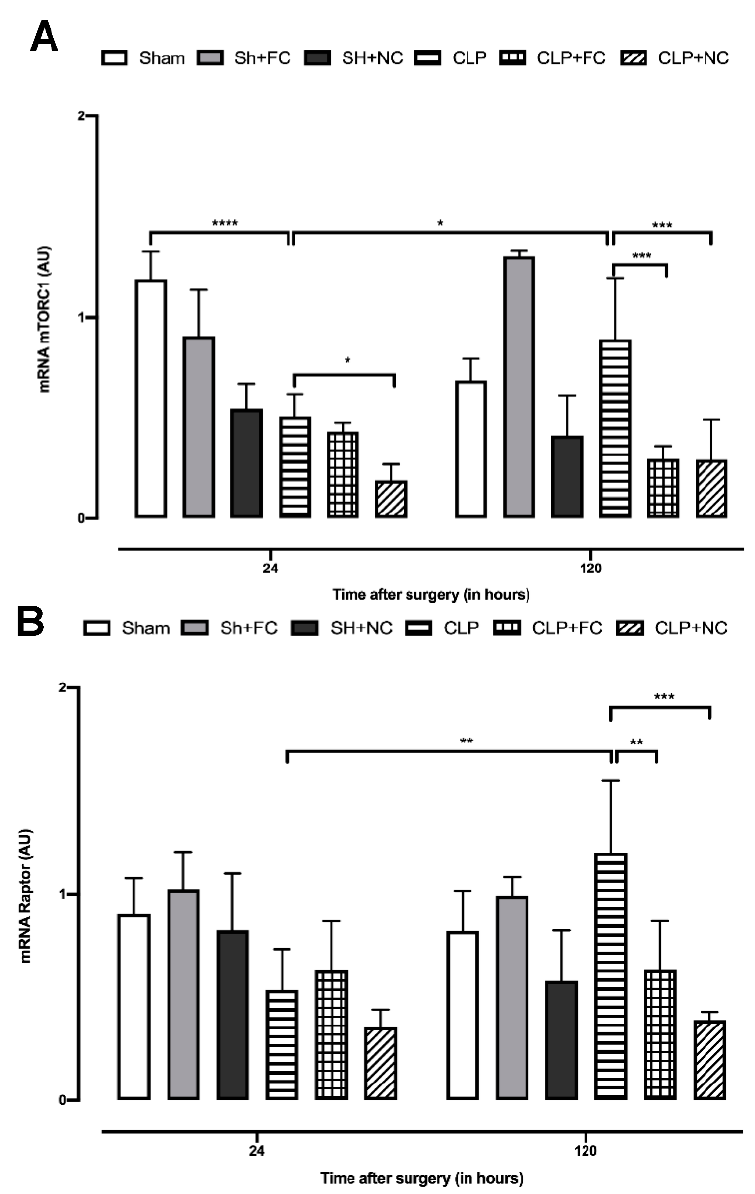
Figure 4. Real-time PCR gene expression profile analysis of mTOCR1 and Raptor in the heart of curcumin-treated and non-treated septic animals. ( A ) Assessment of mTORC1 mRNA levels shows that the septic group (CLP) had a significant reduction ( p < 0.001) compared to the control (SHAM) at 24 h and an increase at 120 h ( p < 0.05). The group of septic animals when treated with nanocurcumin (CLP + NC) showed a reduction in mTORC1 when compared to (CLP) at 24 and 120 h ( p < 0.05 and p < 0.001, respectively). At 24 h, there was no difference in the septic group treated with free curcumin, but at 120 h there is a significant reduction ( p < 0.001) compared to (CLP). ( B ) Raptor analysis shows that there was no difference between either group 24 h after sepsis induction. When comparing the levels of Raptor at 24 h with 120 h, it is noted that there was a significant increase in the (CLP) group ( p < 0.01). At 120 h, there is a reduction in Raptor in the treated septic groups (CLP + FC and CLP + NC) compared with the untreated septic group (CLP) ( p < 0.01 and p < 0.001, respectively). Results are expressed in arbitrary units (AU). p values * p < 0.05; ** p < 0.01; *** p < 0.001; **** p <